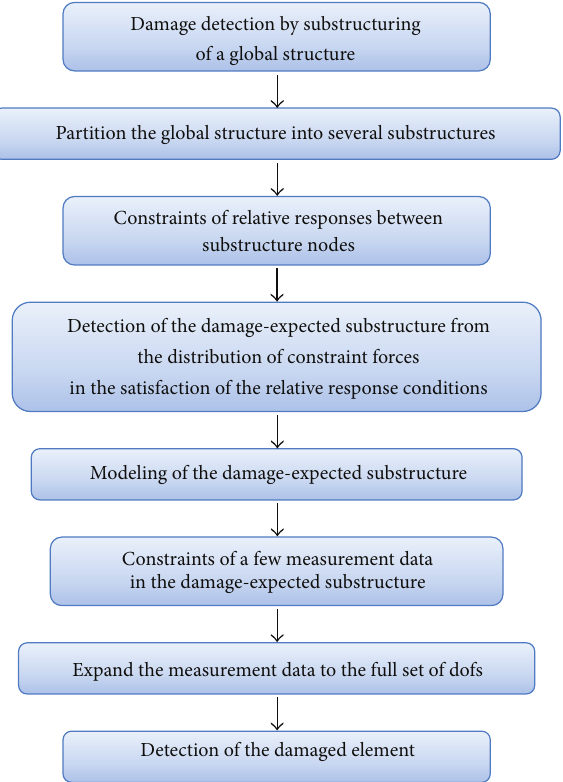
Figure 2: Summary of the proposed substructuring method for damage